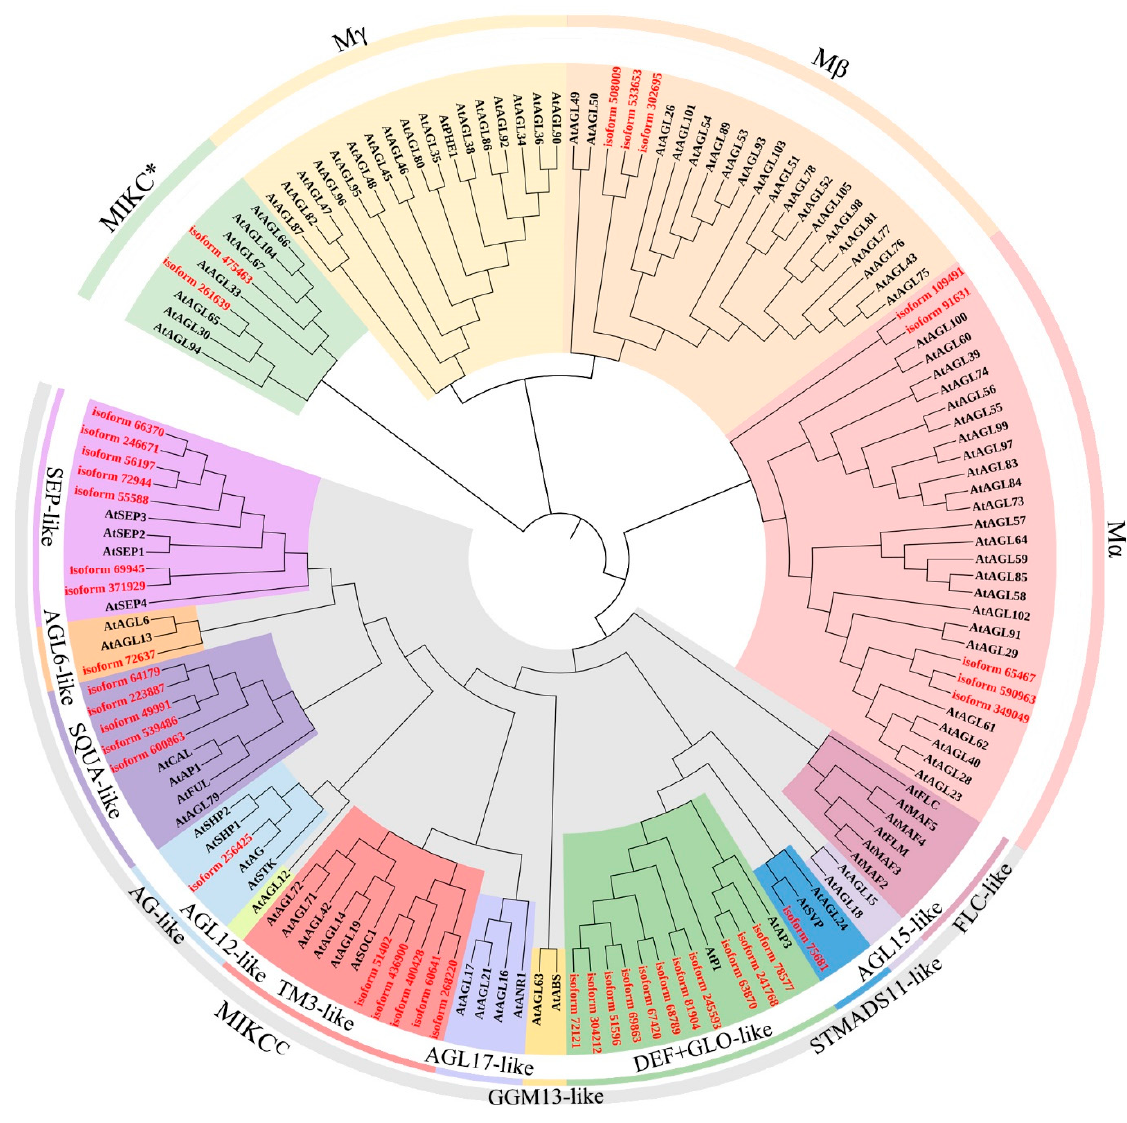
Figure 1. Phylogenetic analysis of MADS-box proteins. Red and black denote MADS-box proteins from I. laevigata and Arabidopsis , respectively.